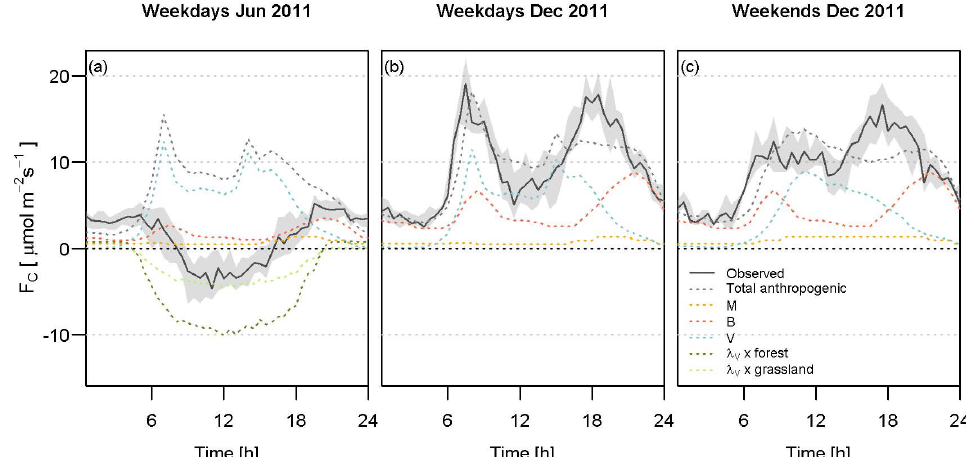
Fig. 14. Diurnal cycle of measured (median: solid lines, interquartile range: shaded) and modelled anthropogenic (mean: dashed lines) carbon fluxes, including components from human metabolism (M), gas usage in buildings (B) and vehicle emissions (V). Uptake by vegetation is modelled for a mixed deciduous forest (Schmid et al., 2000) and temperate grassland (Flanagan et al., 2002) ecosystem scaled by the vegetation fraction for Swindon (a) . Weekdays are shown for June 2011 (a) and weekdays and weekends for December 2011 (b, c)